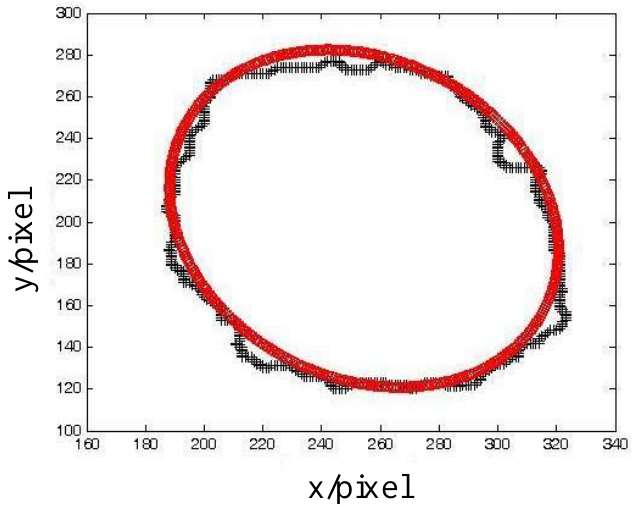
Figure 5. Ellipse fitting of the